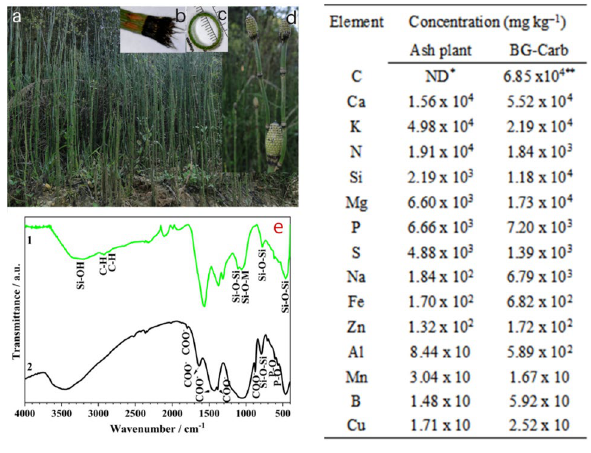
Figure 1. Images of Equisetum hyemale: ( a ) plants in situ ; ( b ) node and leaves; ( c ) stem cross section; ( d ) strobilus ; ( e ) FTIR spectra of the: (1) Equisetum hyemale plant ash, and (2) BG-Carb composite; Concentrations (mg kg −1 , dry weight) of elements in Equisetum hyemale plant ash and in the BG-Carb composite. *ND = not determined; **Determined by the combustion loss